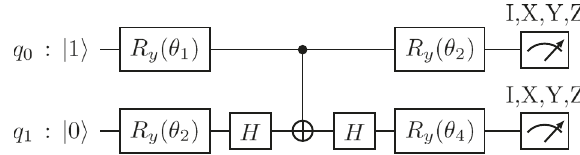
Fig. 7 Quantum circuit implementing the depth-1 R y Ansatz for 2 qubits. The initial bitstring 10 j i corresponds to the Hartree – Fock state, and the rightmost symbol denotes measurement of the Pauli operators de fi ning the qubit representation of the active space